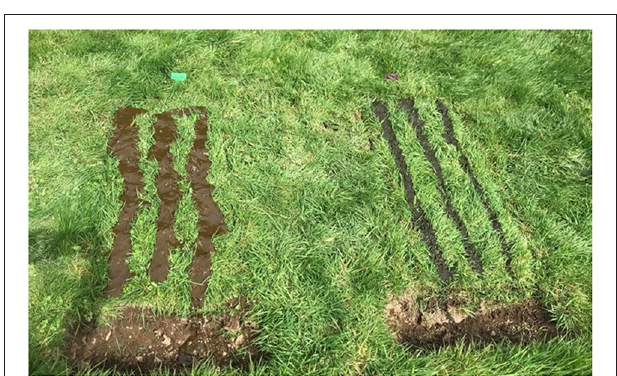
FIGURE 2 | Inoculated slurry (left) and digestate (right) were applied to the microplots in linear rows.